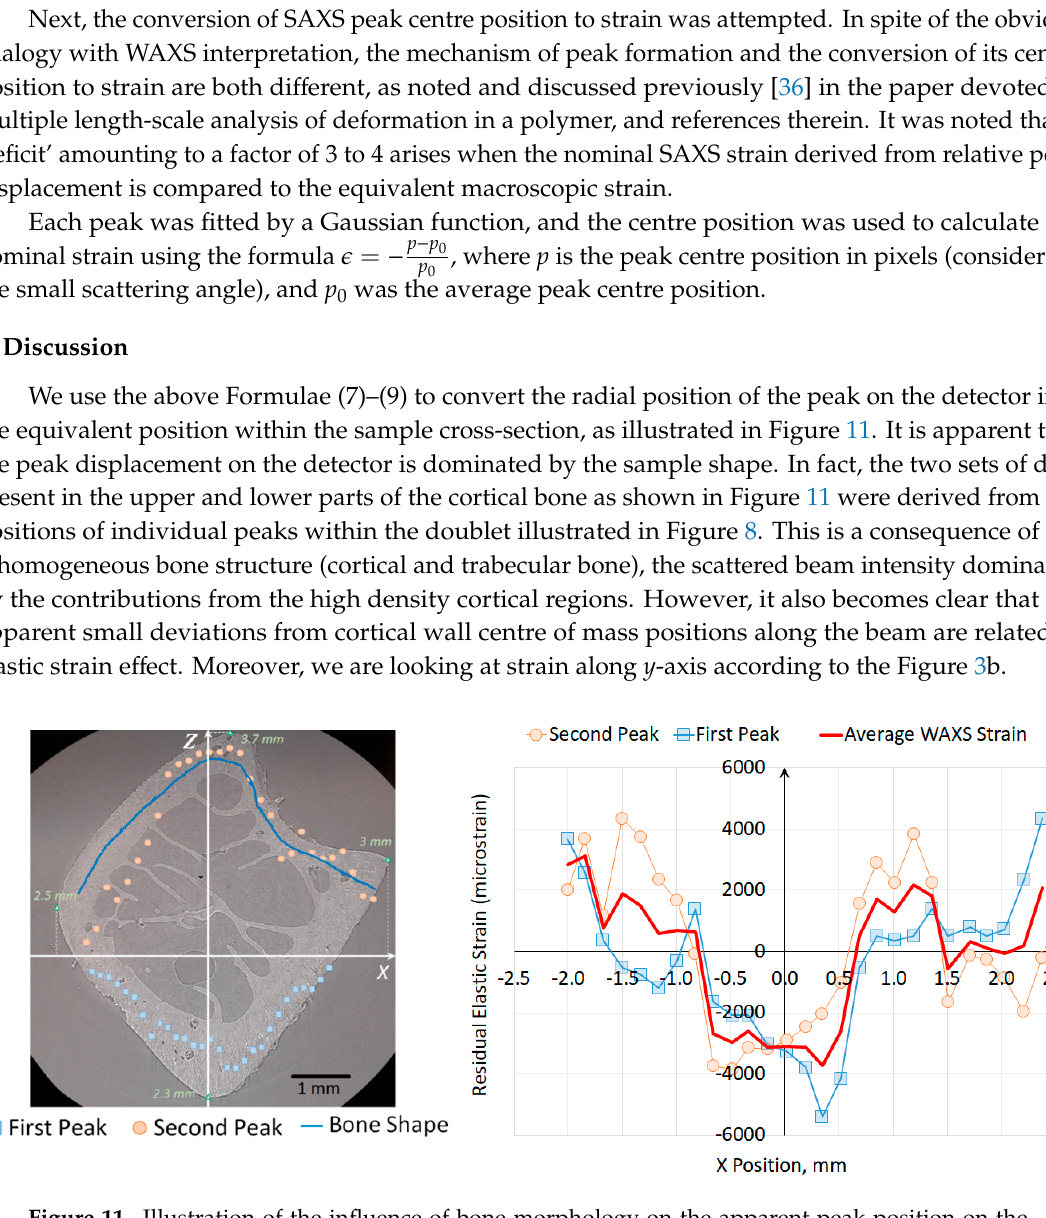
Figure 11. Illustration of the influence of bone morphology on the apparent peak position on the detector, and the extraction of inherent lattice strain by incorporating bone shape correction.